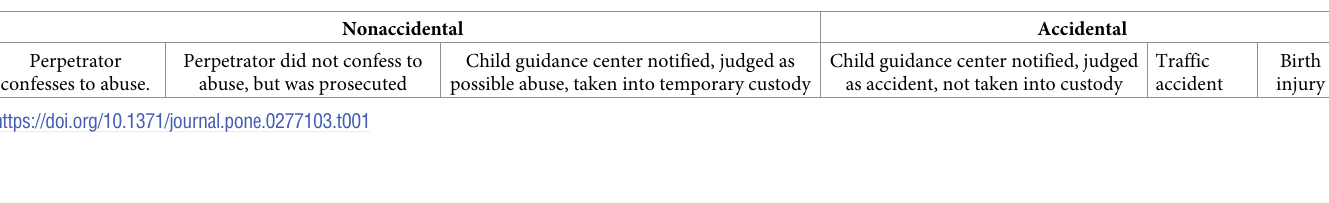
Table 1. Definitions of “nonaccidental” and